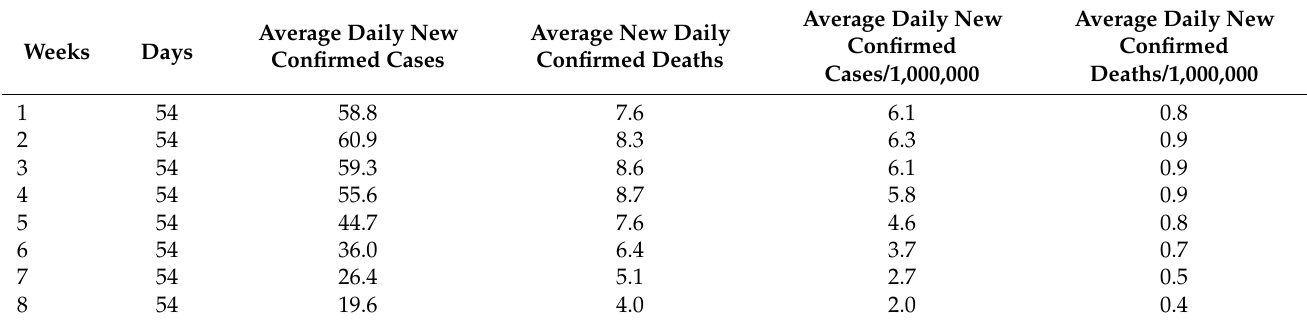
Table 2. Average number of cases during the lockdown in Hungary.